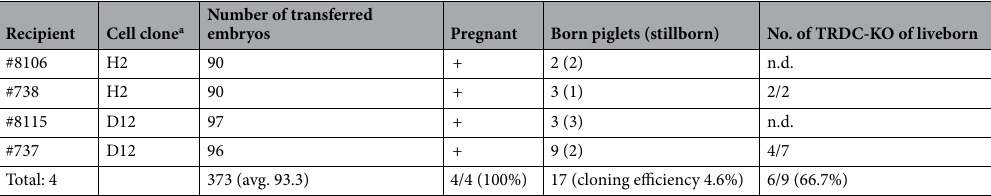
Table 2. Results from somatic cell nuclear transfer employing genetically modified cells as donor cells. a Cell clone D12: mixed population of knockout and wild type cells, cell clone H2: pure knockout cells.